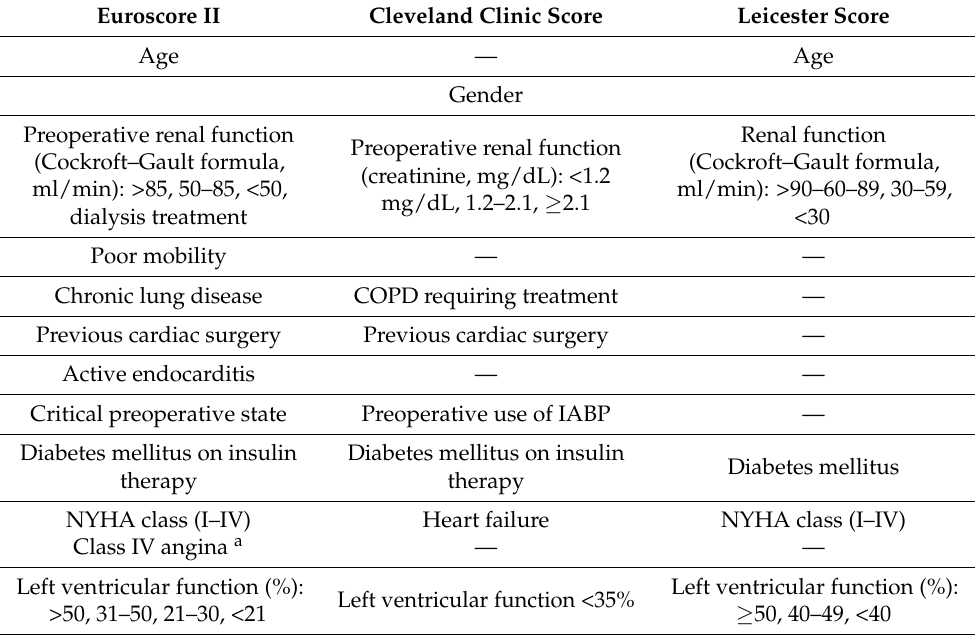
Table 1. Variables included in the EuroSCORE II, Cleveland Clinic Score, and Leicester